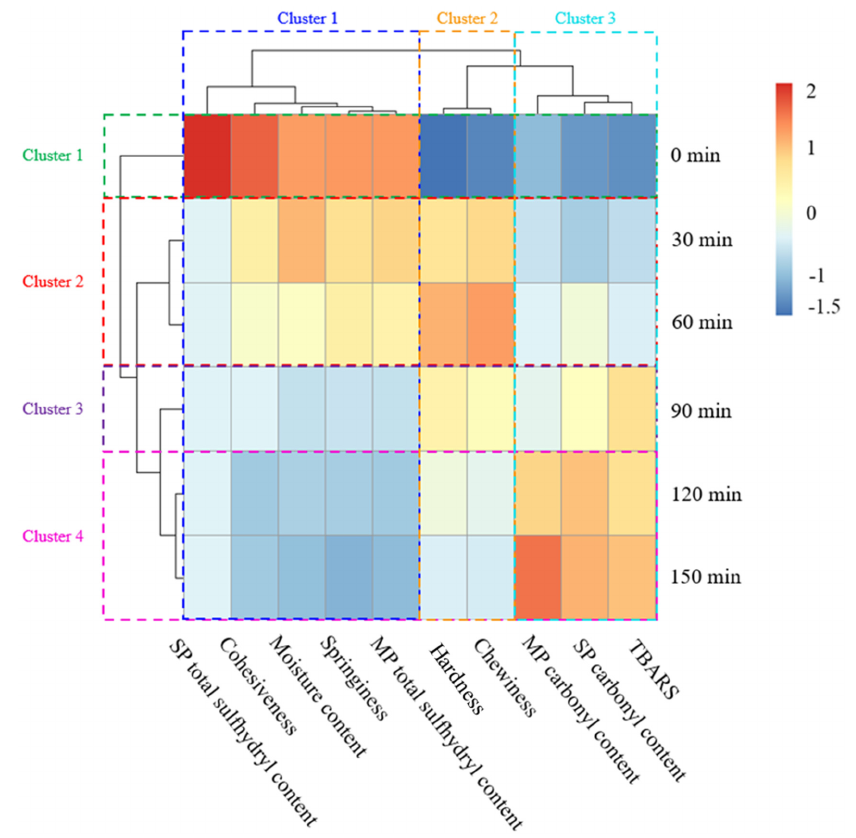
Figure 5. HCA of Sichuan − style braised beef treated by di ff erent stewing times.